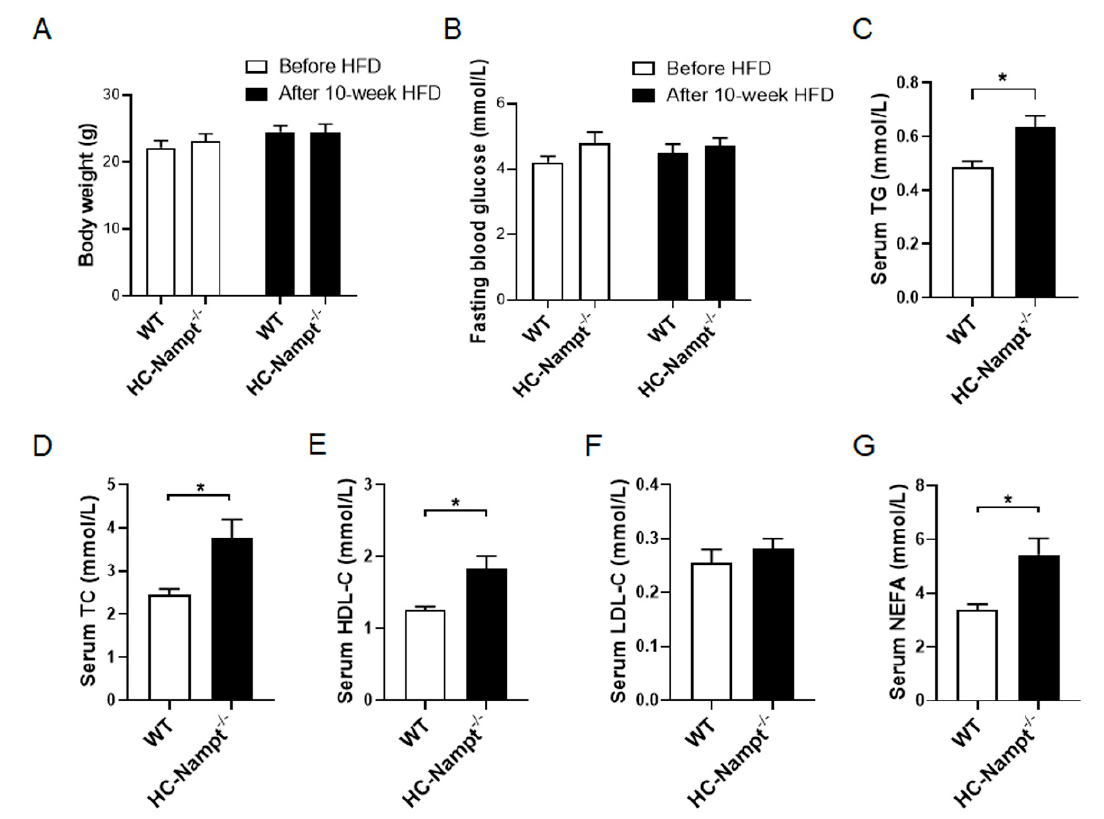
Figure 4. The effects of hepatic Nampt deficiency on body weight, fasting blood glucose, and serum lipids levels in HFD-fed mice. ( A ) Body weight of HC-Nampt -/- and WT mice before and after HFD. ( B ) Fasting blood glucose of HC-Nampt -/- and WT mice before and after HFD. ( C – G ) Serum lipids levels of HC-Nampt -/- and WT mice after 10 weeks of HFD. TG, triglycerides; TC, total cholesterol; HDL-C, high-density lipoprotein cholesterol; LDL-C, low-density lipoprotein cholesterol; NEFA, non-esterified fatty acids. Data are expressed as the mean ± SEM. n = 6 (WT) or 8 (HC-Nampt -/- ). * p < 0.05 between two groups by two-tailed Student’s t -test.